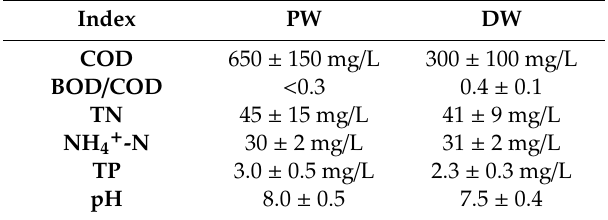
Table 1. The basic water quality of pharmaceutical wastewater and domestic wastewater.